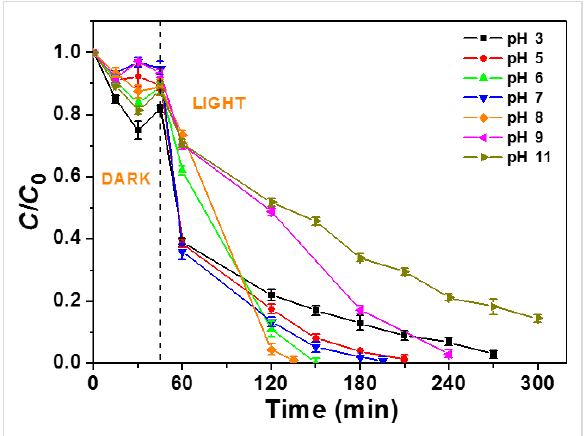
charge of the catalyst and the structure of the dye in solution.